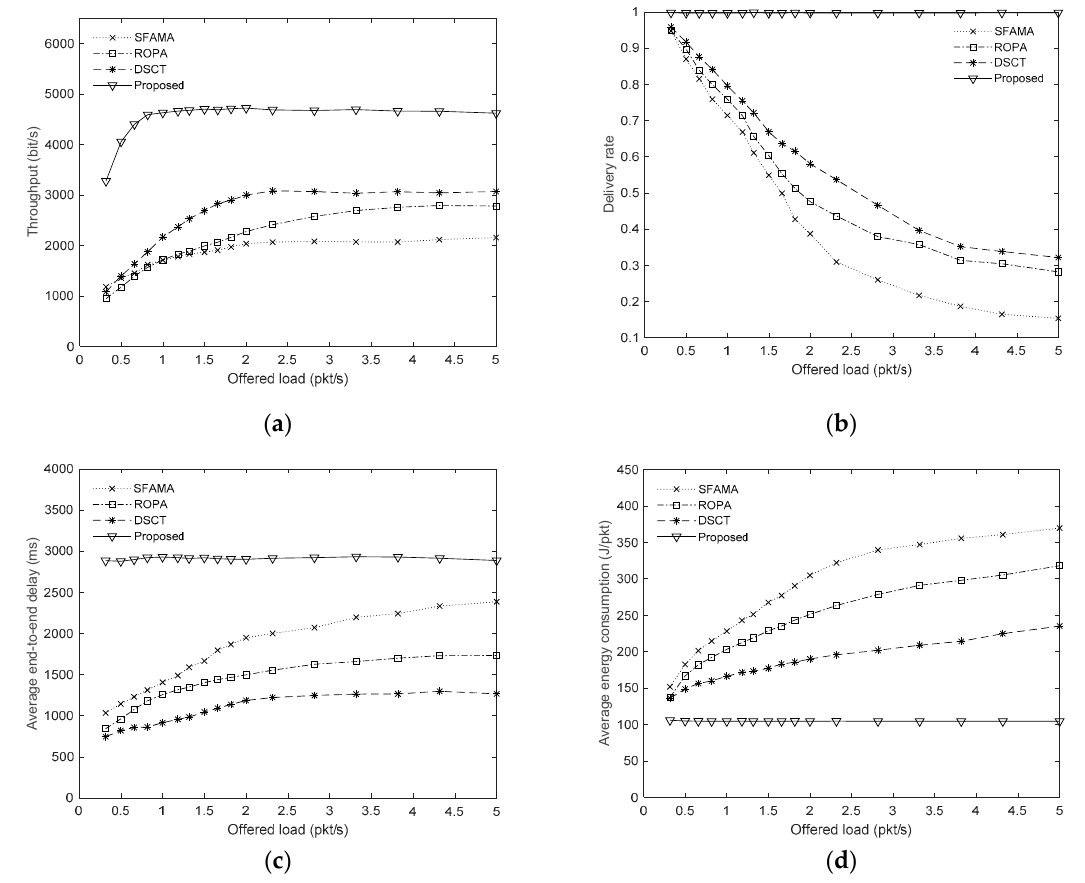
Figure 7. Performance of the slotted floor acquisition multiple access (SFAMA), reverse opportunistic packet appending (ROPA), and distributed scheduling based concurrent transmission (DSCT) protocols and that of the proposed method under different network loads. ( a ) throughput; ( b ) packet delivery rate; ( c ) average end-to-end delay; and ( d ) average energy consumption.